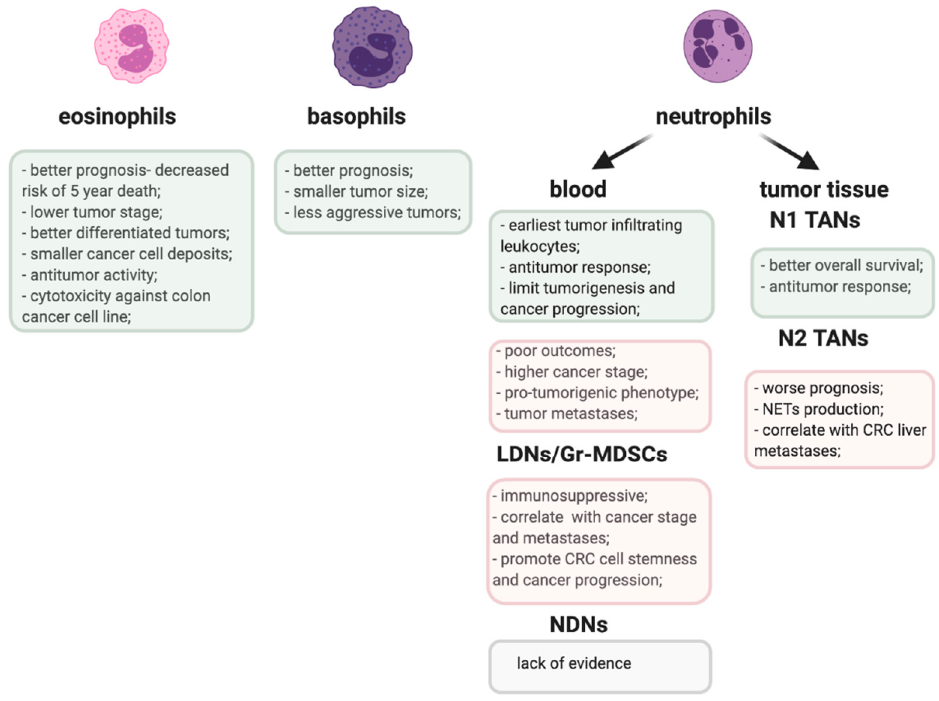
Figure 1. Pro-(pink) and anti-tumorigenic (greenish) activities of granulocyte populations in CRC. 9. Gr-MDSCs—The ‘Bad Guys’ in Anti-Tumor Immune Response Gr-MDSCs together with monocytic (Mo-MDSCs) and early stage (e-MDSCs) belong to the group of immature myeloid cells with strong immunosuppressive properties [88]. Their level in peripheral blood rises in many pathological conditions, including cancer [89]. Accumulation of MDSCs in cancer is mainly due to the action of inflammatory cyto- kines released by cells of the tumor microenvironment [90]. MDSCs are capable of sup- pressing antigen-specific T cell response, their proliferation and IFN γ production [91]. Moreover, their ability to suppress T-cell response can be arranged also by the induction of Treg cells [10,11]. As a result of interactions with other cells, MDSCs manifest their immunosuppressive character and promote tumor progression [92]. Both in the murine models and CRC patients, the level of circulating and tumor res- ident MDSCs correlate with cancer stage and metastasis development [93]. However, an increased level of MDSCs was also noted in CRC premalignant stage—colon polyposis [94] and IBD, considered as a risk factor for CRC development [95]. Although, there is no agreement in respect to the predominant role of specific MDSCs subset in CRC develop- ment and progression [96], the importance of Gr-MDSCs in that process is unquestionable [94,97–100]. Gr-MDSCs morphologically resemble neutrophils, however they differ from the latter in functions. In particular, Gr-MDSCs are less phagocytic, have higher activity of Arg-1 and myeloperoxidase, produce more ROS and show lower chemotaxis, e.g., to- ward the supernatants from human cancer cells [101]. Gr-MDSCs possess strong immu- nosuppressive properties, which normal PMN do not show [91,102]. So far, several mech- anisms regulating the action of Gr-MDSCs in CRC have been described [103]. Gr-MDSCs are the primary cells in CRC that express IL-6 in response to inflammation in colon epi- thelium and local environment, suggesting Gr-MDSCs to be essential for CRC develop- ment [104]. Mundy-Bosse et al. confirmed in humans, what was previously observed in mice, the correlation between the CD15+ MDSCs (Gr-MDSCs) and IL-6 level as well as between CD14+ MDSCs (Mo-MDSCs) and IL-10, suggesting that the balance between